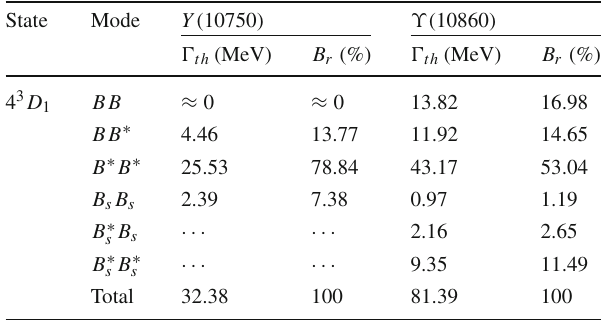
Table 4 Strong decays for the ϒ 1 ( 4 D ) which is assigned to be Y ( 10750 ) or ϒ( 10860 ) within the screened potential model